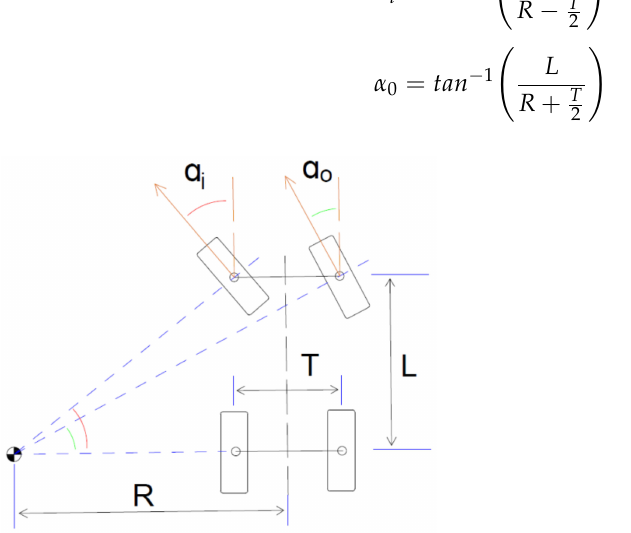
Figure 10. Ackermann’s steering geometry